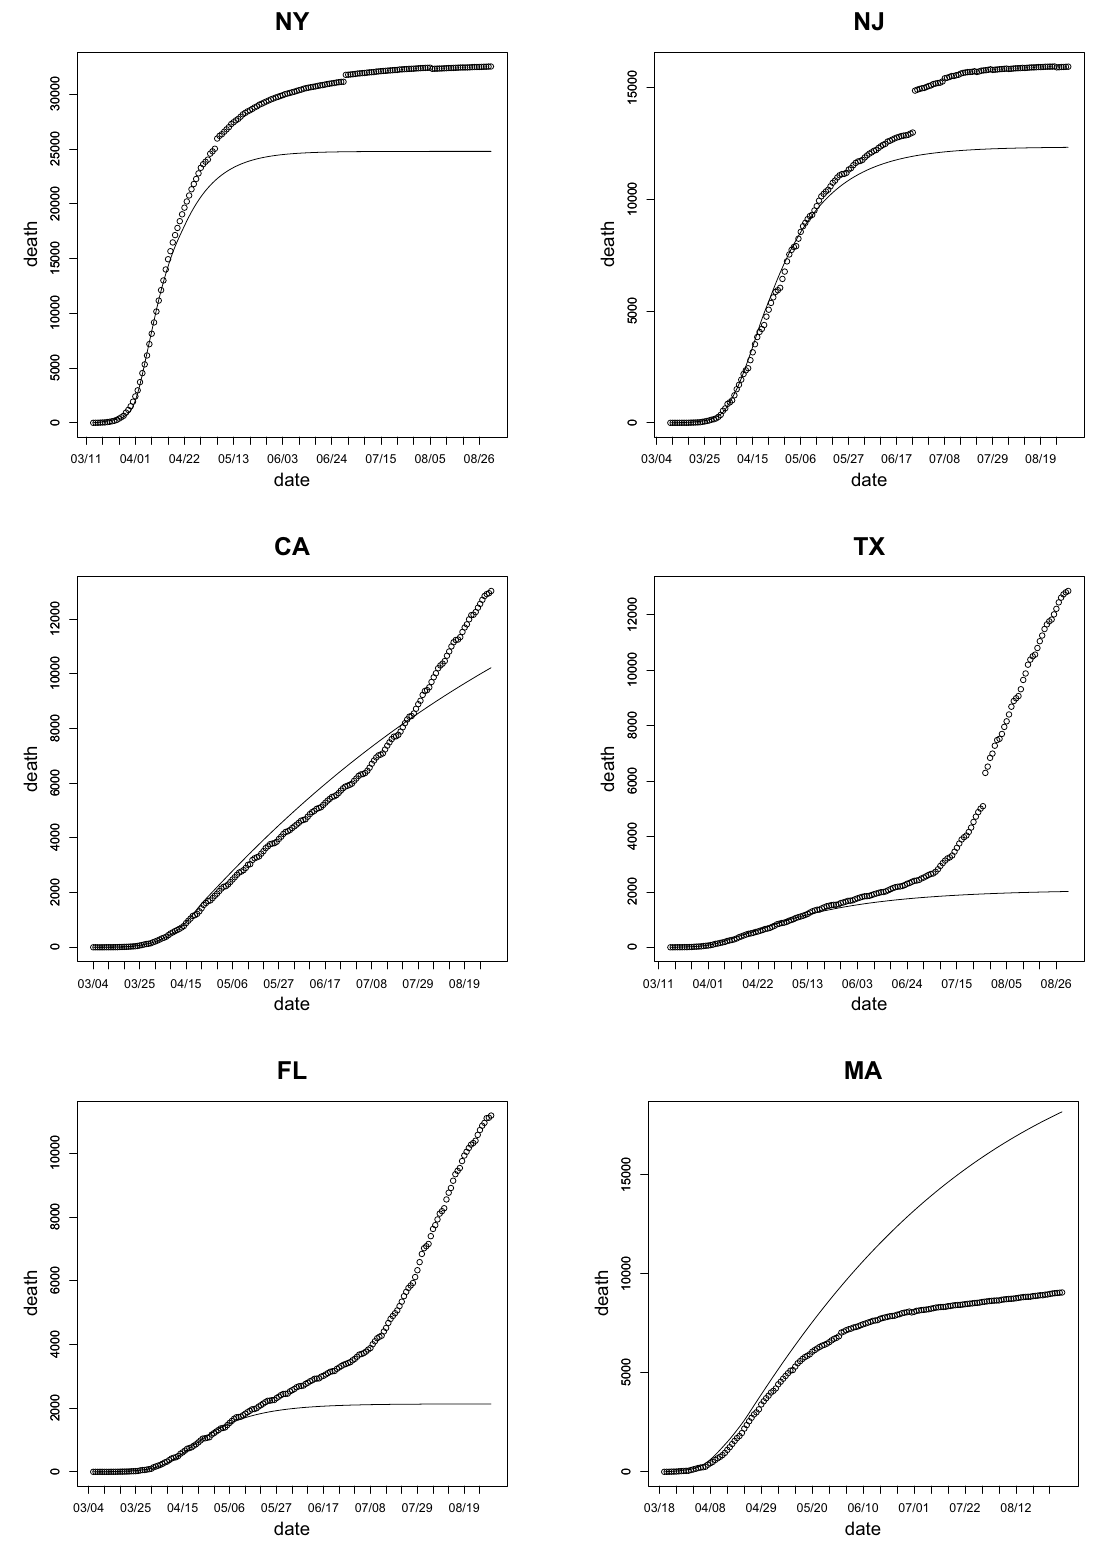
Figure 1. Total death count (dots) 80 and projected death count without easing the mitigation (solid line) as functions of time for the states of New York, New Jersey, California, Texas, Florida, and Massachusetts using estimate by the data before the end of